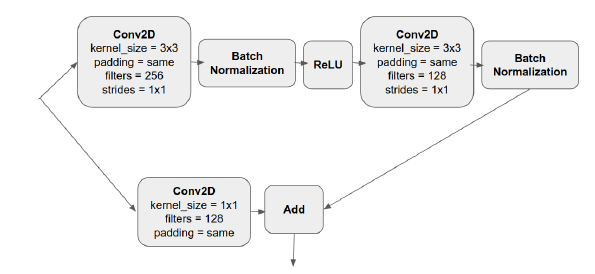
Figure 3. Convolutional Block Type 2 for the MM model shown in Figure 1.